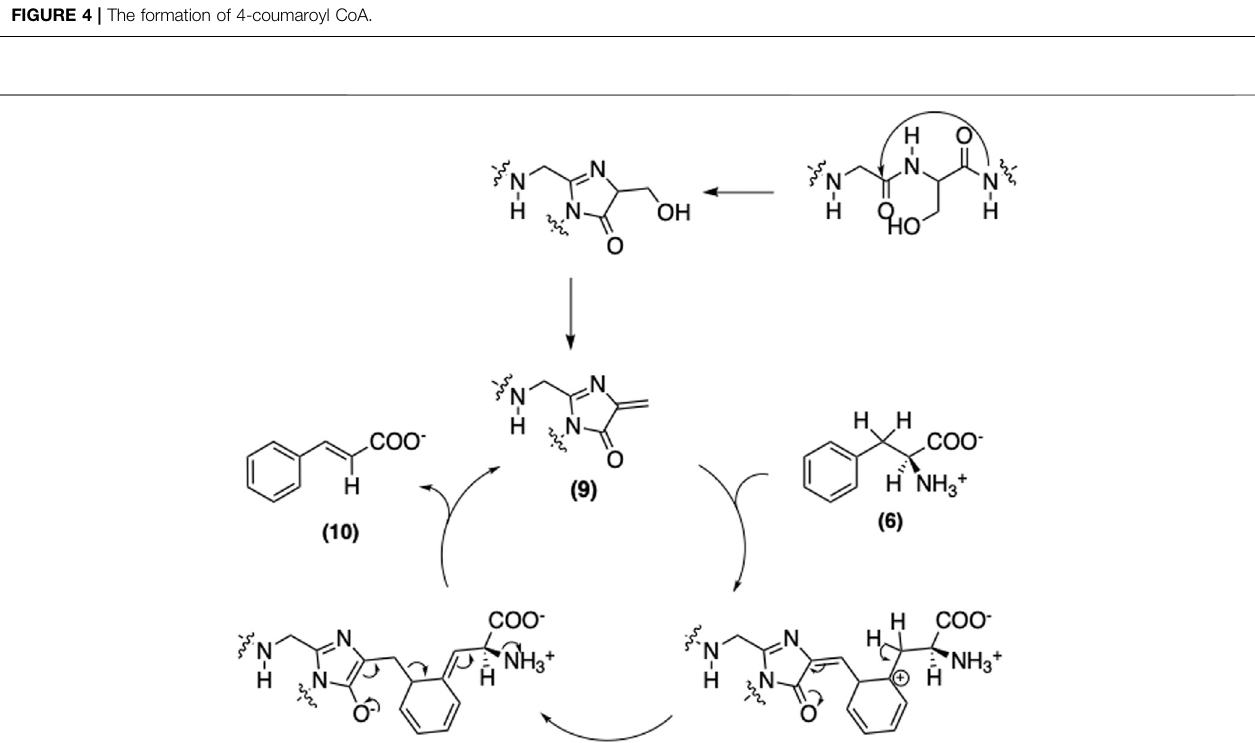
FIGURE 5 | Mechanism of the deamination of phenylalanine catalyzed by PAL.